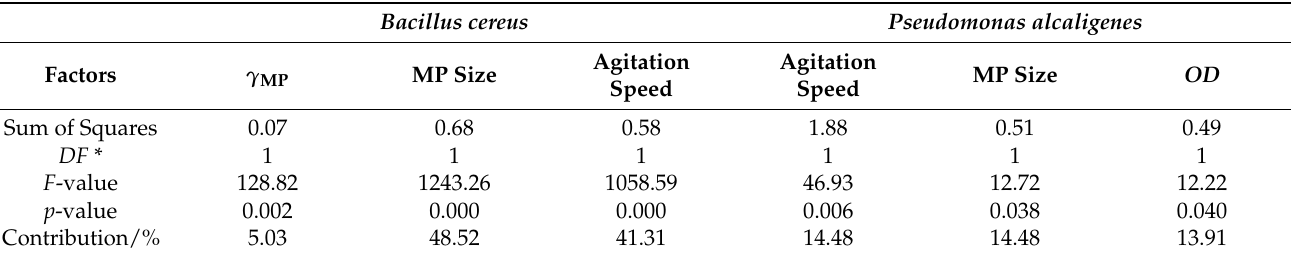
Table 3. Results of preliminary experiments designed by the Taguchi method for biodegradation of MP-PS by Bacillus cereus and Pseudomonas alcaligenes . Bacillus cereus Pseudomonas